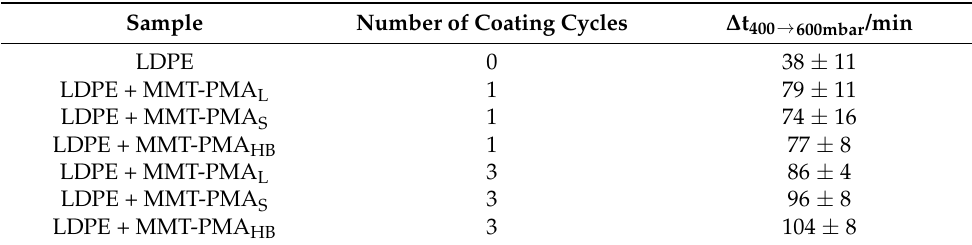
Table 2. Average durations ∆ t 400 → 600mbar —the time difference between 400 and 600 mbar in the sample chamber—for LDPE-foils coated with MMT nanosheets modified with PMA L , PMA S or PMA HB . Errors are obtained as the standard deviation of at least three measurements. Reprinted from Ref.